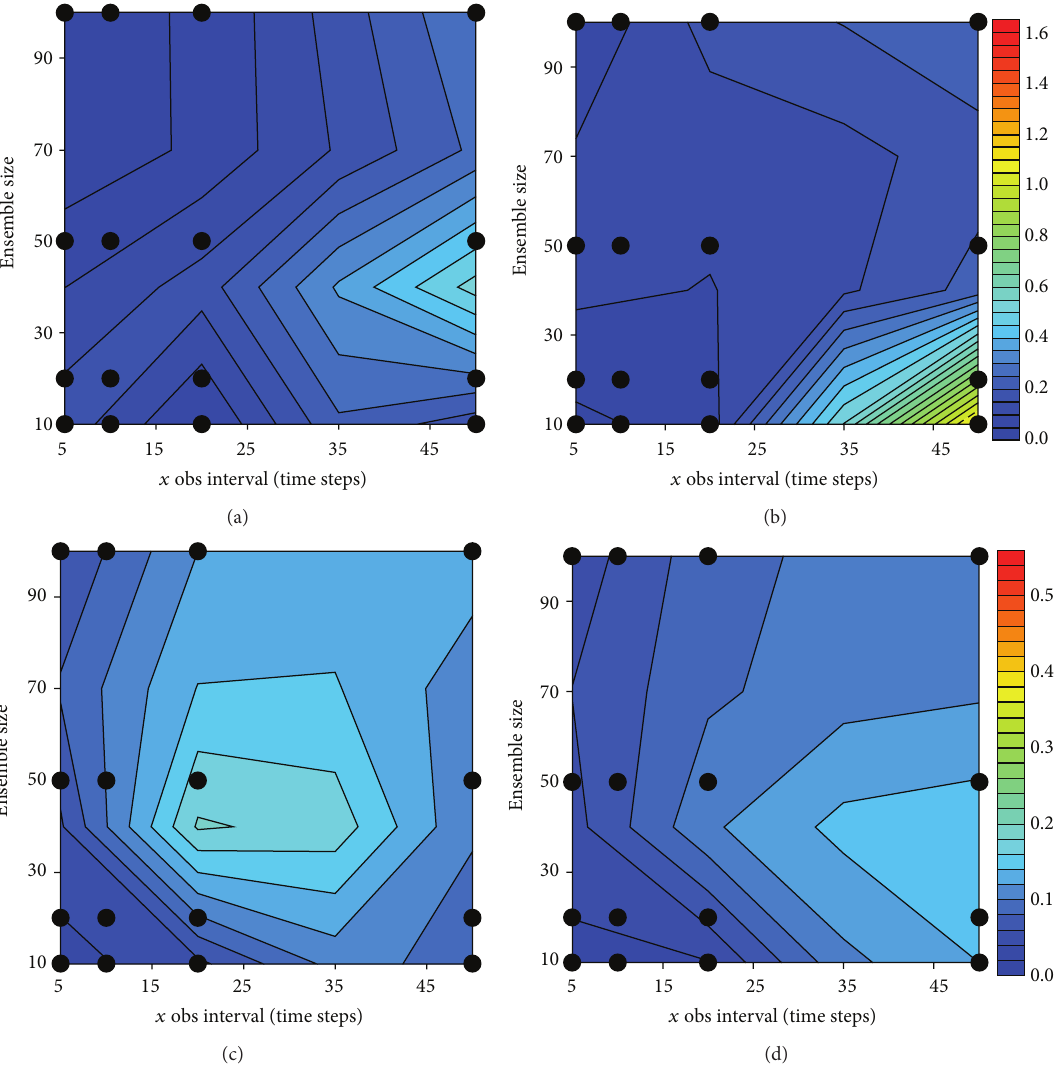
Figure 7: Same as Figure 3 but for the EnKF CPE. Note that panels (a) and (b) use the upper shade scale while panels (c) and (d) use the lower shade